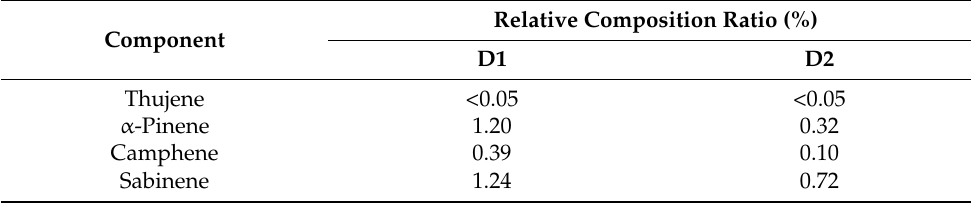
Table 1. Constituents identified from two different Origanum vulgare essential oil formulations (D1 and D2) by gas chromatography